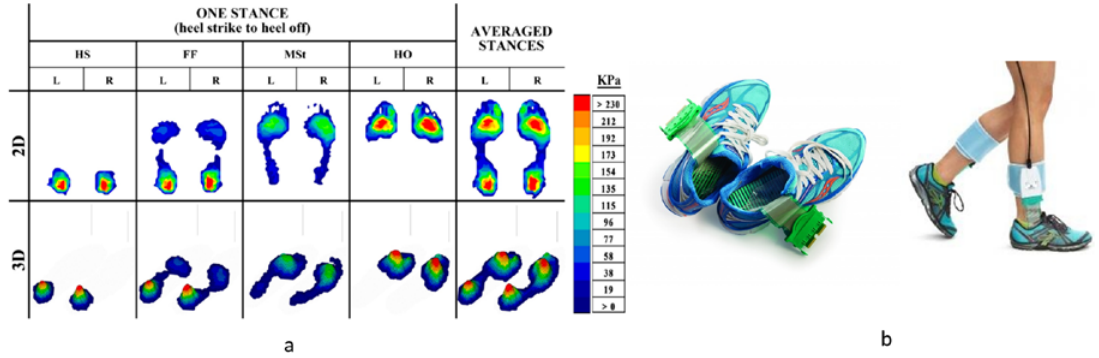
Figure 2. ( a ) Plantar pressure map during one stance [27]. HS—heel strike, FF—foot flat, MSt—mid stance, HO—heel off; and ( b ) F-Scan ® System, courtesy of Tekscan, Inc. (Boston, MA, USA).